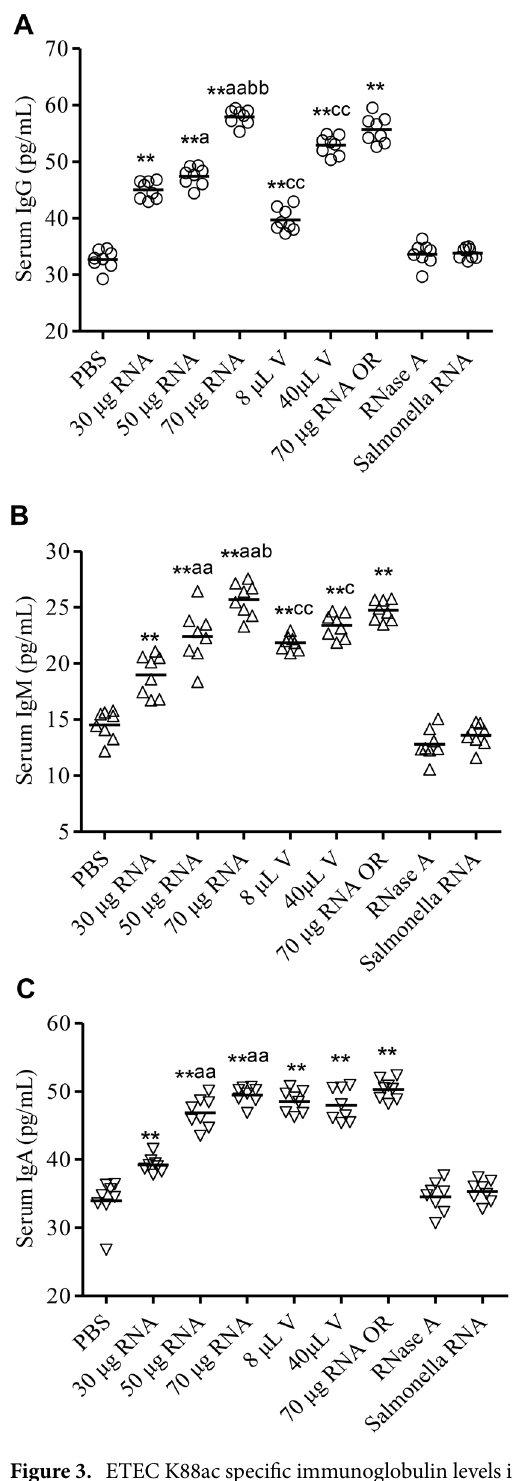
Figure 3. ETEC K88ac specific immunoglobulin levels in the serum of the immunized mice. The eight experimental groups of mice (n = 8) were intramuscularly injected with PBS, ETEC total RNA (30 μg RNA; 50 μg RNA; 70 μg RNA), ETEC vaccine (8 μL V; 40 μL V), RNase A treated ETEC RNA (labeled as RNase A) and 70 μg Salmonella RNA in a total volume of 100 μL. The ninth group of mice (n = 8) was orally immunized with 70 μg ETEC total RNA. The serum concentrations of IgG ( A ), IgM ( B ), and IgA ( C ) were measured at 20 dpi using ELISA. ** P < 0.01 compared with the PBS control group. aa P < 0.01, a P < 0.05, compared with the 30 μg ETEC RNA administrated mice. bb P < 0.01, b P < 0.05 compared with the 50 μg ETEC RNA administrated mice. cc P < 0.01, c P < 0.05 compared with the 70 μg ETEC RNA administrated